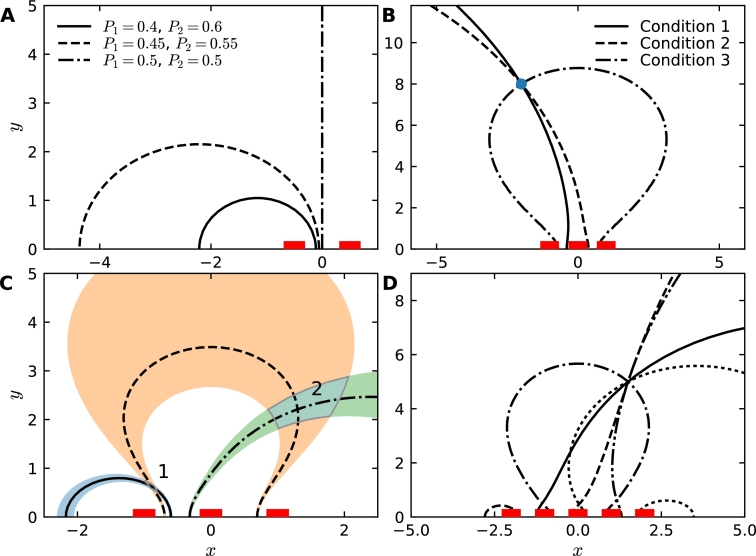
Reconstruction of the source position in the half-plane. (A) Two windows placed a distance d = 1 apart allow the recovery of the source position up to a curve. Three different flux configurations are shown. (B) Three windows positioned at y = −1,0,1 yield two independent curves, the intersection of which is the position of the source at x0 = (−2,8). The redundant third condition is shown for completeness. (C) The shaded areas indicate the uncertainty resulting from fluctuations in the fluxes with an amplitude of η = 0.005. The resulting sensitivity of the reconstructed source position (overlapping shaded areas 1 and 2) is highly inhomogeneous. (D) Five windows with nearest-neighbor distance d = 1 yield four independent curves. The point of intersection of all curves is the recovered source position.